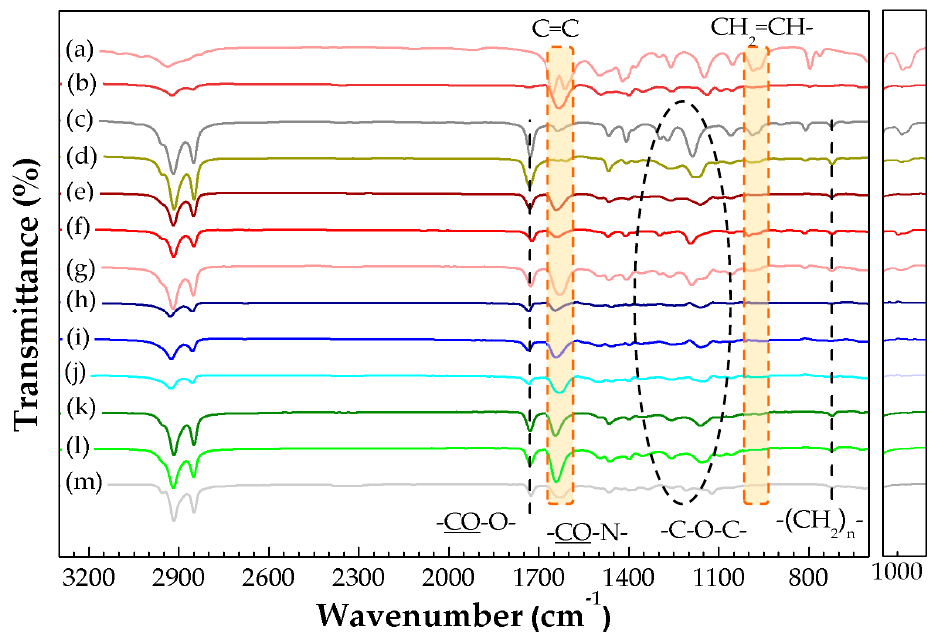
Figure 7. Fourier Transform Infrared Spectrometer (FTIR) spectra of P(SA-DMAA) gels and their partial enlargement around 1000 cm − 1 . ( a ) DMAA, ( b ) P(DMAA), ( c ) SA, ( d ) P(SA), ( e ) 3DP 0.50, ( f ) 3DP 0.33, ( g ) 3DP 0.25, ( h ) Post-UV 3DP 0.50, ( i ) Post-UV 3DP 0.33, ( j ) Post-UV 3DP 0.25, ( k ) Mold 3DP 0.50, ( l ) Mold 3DP 0.33, ( m ) Mold 3DP 0.25.